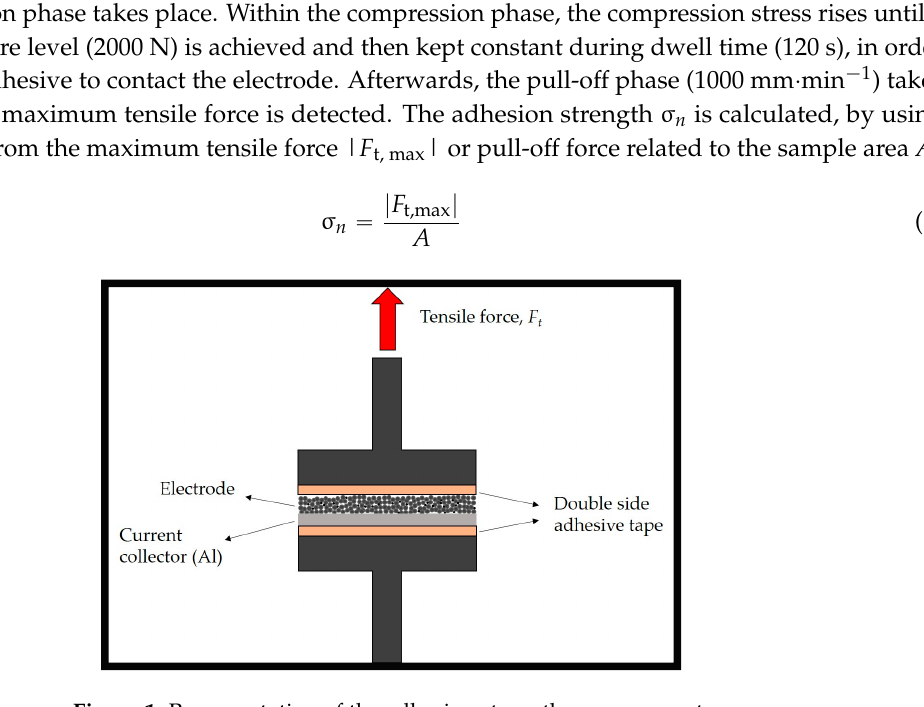
Figure 1. Representation of the adhesion strength measurement.